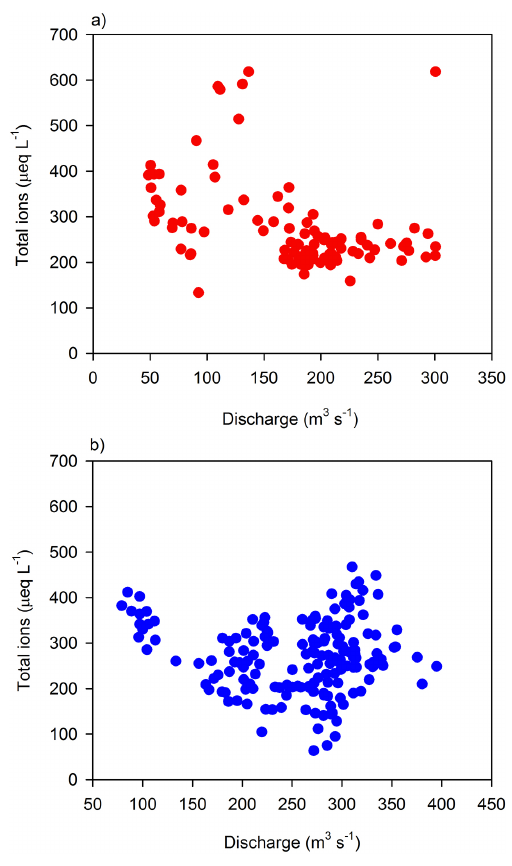
Figure 3. Comparing discharge with total ion concentration (snow- pack corrected) in (a) 2009 and (b) 2010 subglacial runoff. Note the lack of linear correlation between the two variables in both years ( R 2 = 0 . 0239 and 0.0031 in 2009 and 2010,